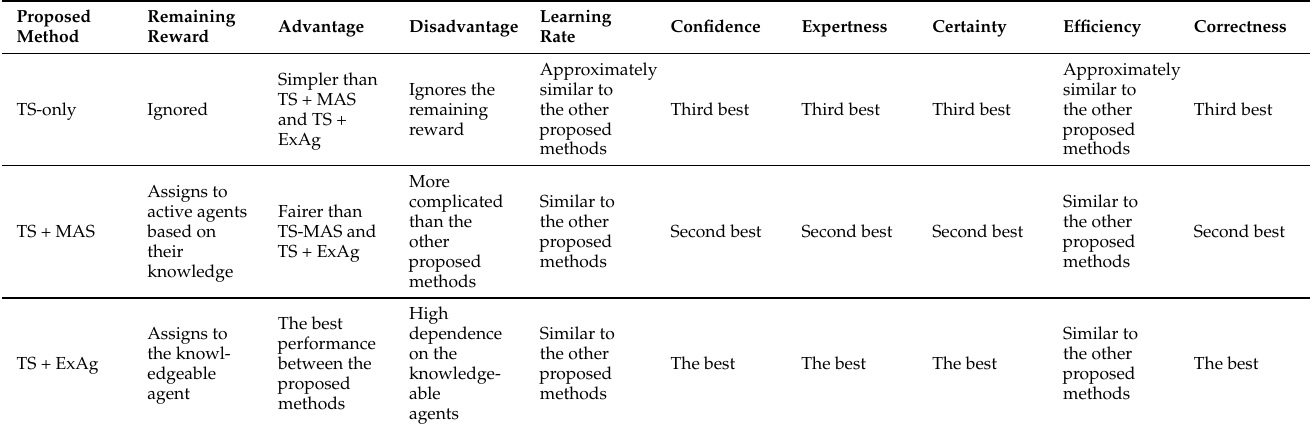
Table 2. Comparing the proposed methods to solve the